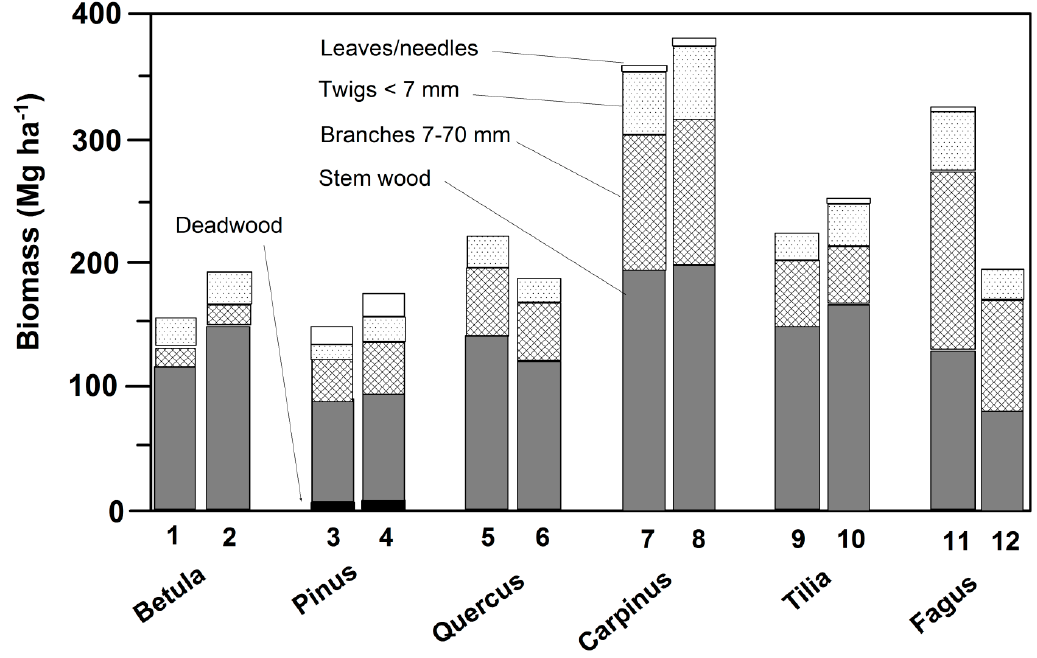
Figure 1. Biomass stocks in the 12 studied forest stands of the six tree species by fraction. Deadwood refers to dead branches attached to the stem. The leaf / needle fraction was too small to be depicted in the bars in several stands. The species are arranged according to their position in forest succession.